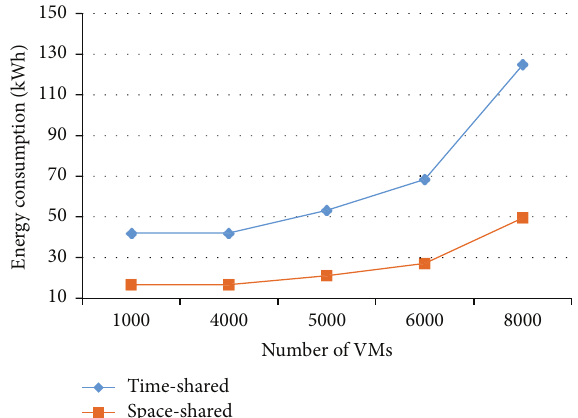
Figure 11: Energy consumption and amounts of VMs.